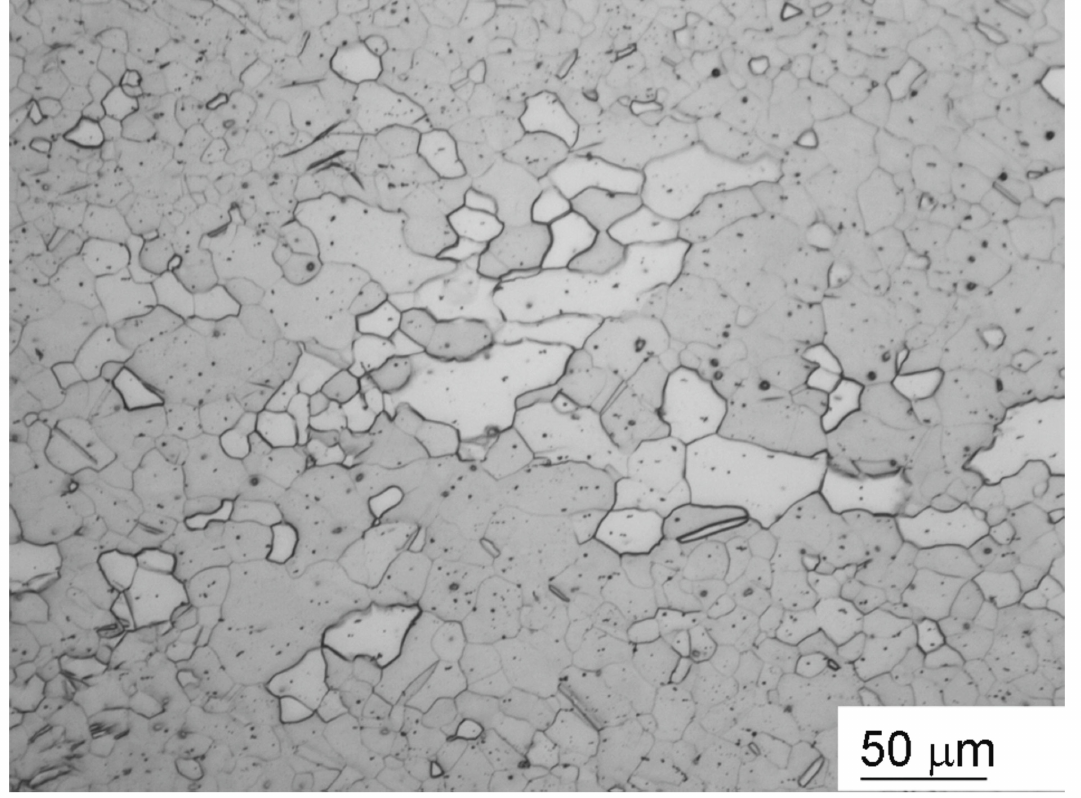
Figure 1. The optical microstructure of AZ31 base